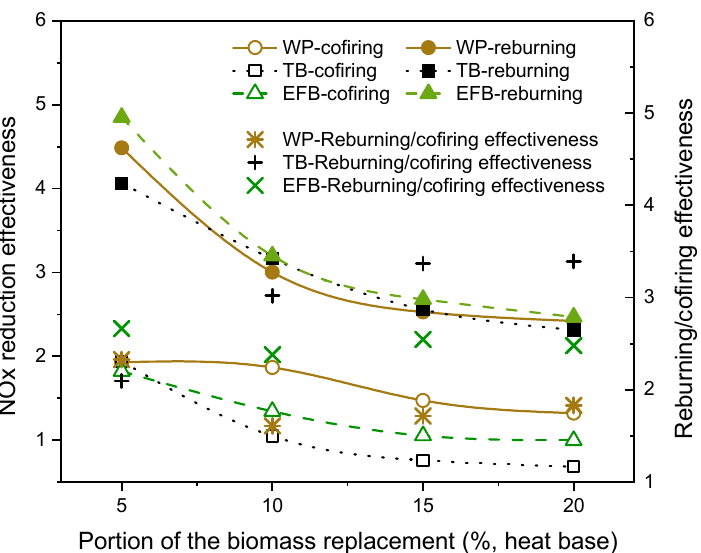
Figure 7. NOx reduction effectiveness and effectiveness ratios of reburning over cofiring for various types and replacement ratios of the biomasses.